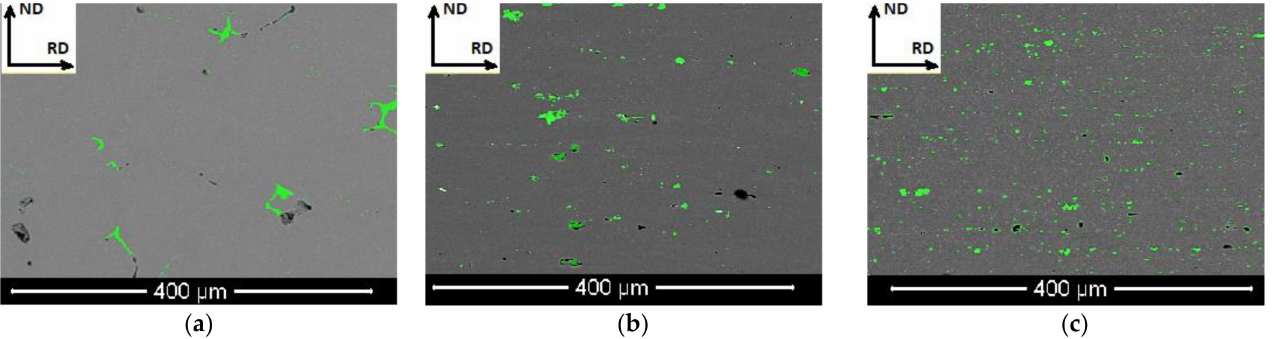
Figure 11. Micrographs of samples etched to reveal 1565 alloy phases: ( a ) 32.2% deformation, ( b ) 67.13% deformation, ( c ) 83.53% deformation.